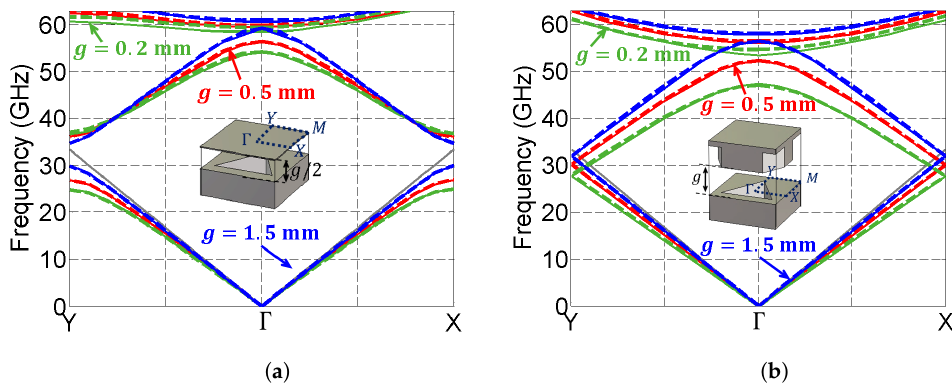
Figure 5. Dispersion diagram of the ( a ) mirror-symmetric and ( b ) glide-symmetric unit cells when varying the gap between the metallic plates. Dashed lines represent the results extracted from CST and solid lines the results extracted from the mode-matching. The light line is displayed in gray. The geometrical parameters of the unit cells are: h hole = 1.5mm, h t = 3mm, and d x = d y =